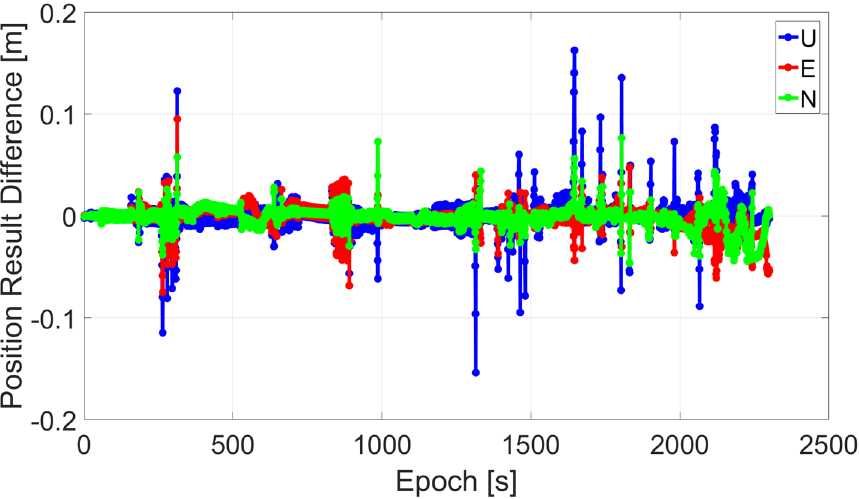
Figure 13. Position result difference for ENU for the kinematic test.